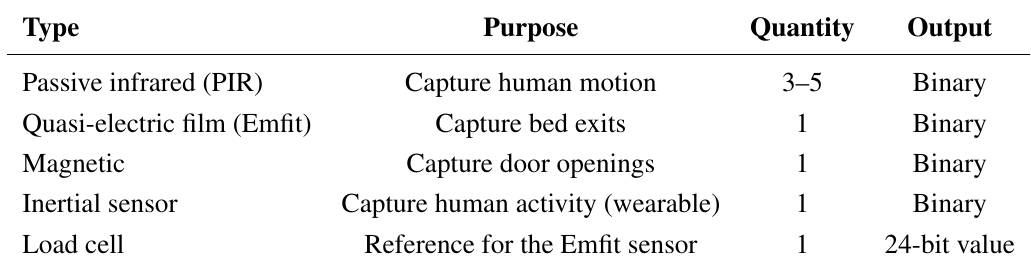
Table 1. Sensors used in the “Trygg om natten” (Safe at night) project